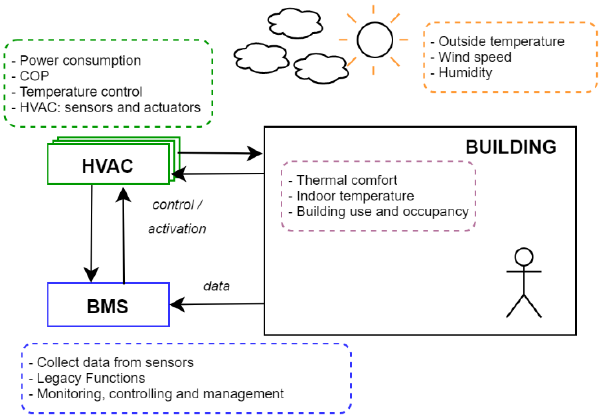
Figure 1. Management of the building environment and the HVAC system using a BMS.